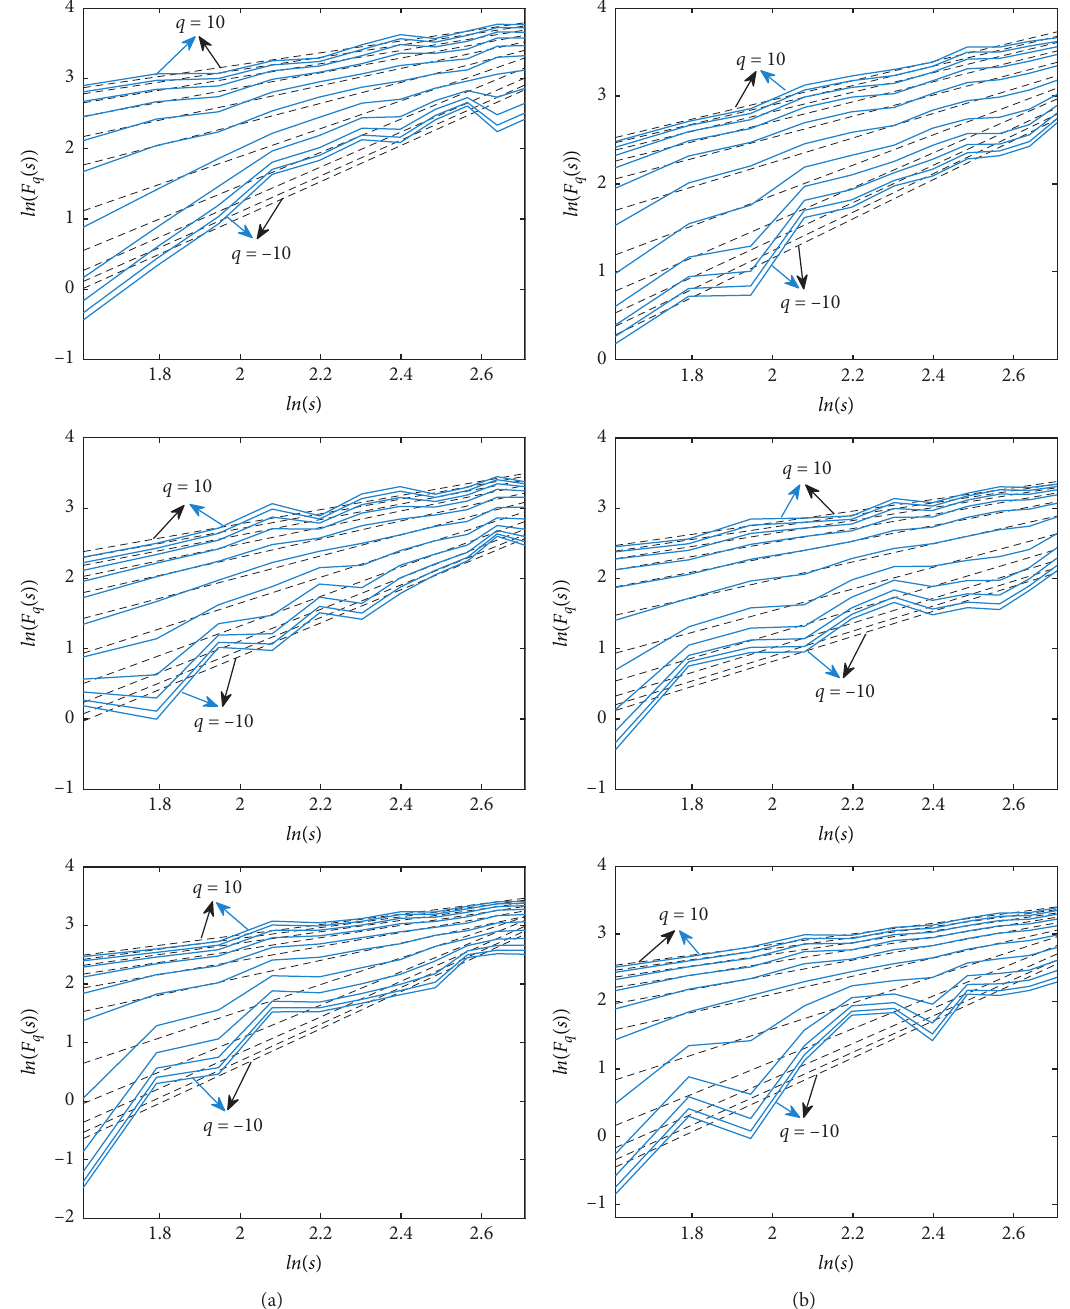
Figure 8: Log-log plots of the fluctuation function F are Seoul, Busan, and